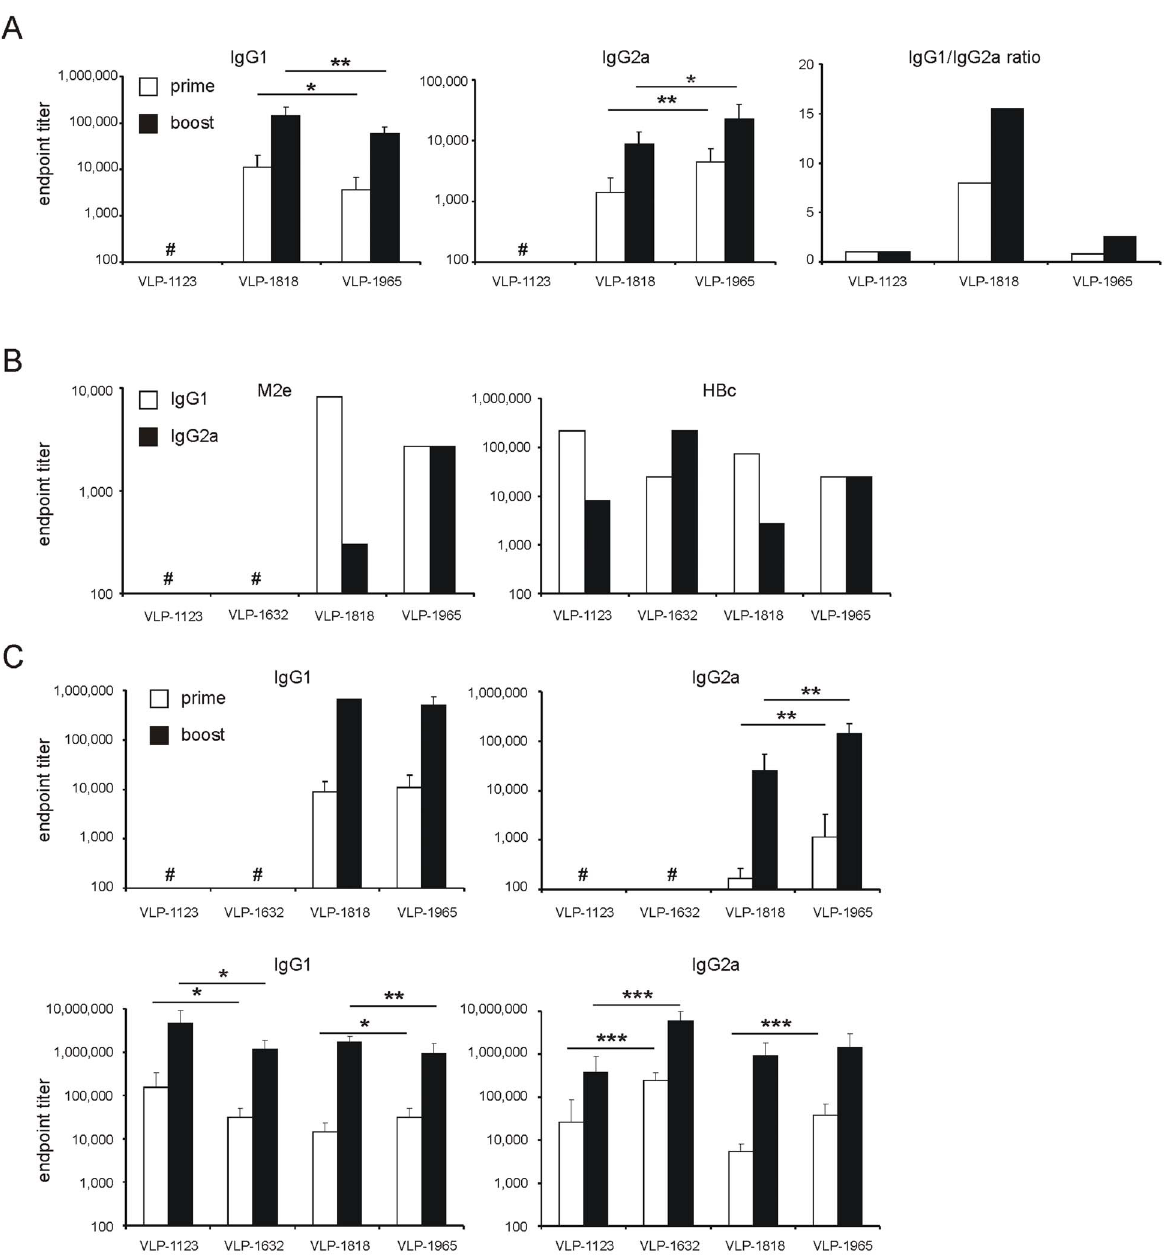
Figure 2. VLPs containing nucleic acids promote a Th1-polarized humoral immune response. A . Three groups of 16 BALB/c mice were immunized twice intraperitonealy with 10 m g of VLP-1123, VLP-1818 or VLP-1965, without adjuvant. Priming and boosting injections were given at three week intervals. Two weeks after the boost, M2e-specific serum IgG1 and IgG2a titers were determined by M2e peptide ELISA. White and black bars: serum samples after priming and boosting, respectively. IgG1/IgG2a ratios were calculated by dividing the mean of the IgG1 endpoint titers by the mean of the IgG2a endpoint titers, and are shown on the right. (*: P , 0.05, **: P , 0.01 two-sample t-test). B . The particles were adjuvanted with Alhydrogel and used to immunize BALB/c mice (14 per group, 10 m g of VLP i.p. per animal). Two weeks after priming, M2e-specific (left) and HBc- specific (right) IgG1 and IgG2a titers were determined in sera pooled from the 14 mice. C . Groups of 12 BALB/c mice were immunized twice by i.p. injection of 10 m g of VLP-1123, VLP-1623, VLP-1818 or VLP-1965 formulated with Alhydrogel. Priming and boosting injections were three weeks apart. M2e-specific serum IgG1 and IgG2a titers are shown in the top panels and HBc-specific titers in the bottom panels. White and black bars: serum samples two weeks after priming and boosting, respectively. (*: P , 0.05, **: P , 0.01, ***: P , 0.001, two-sample t-test). Bars in A and C represent averages and error bars represent standard error of the mean. # : titer lower than 100.